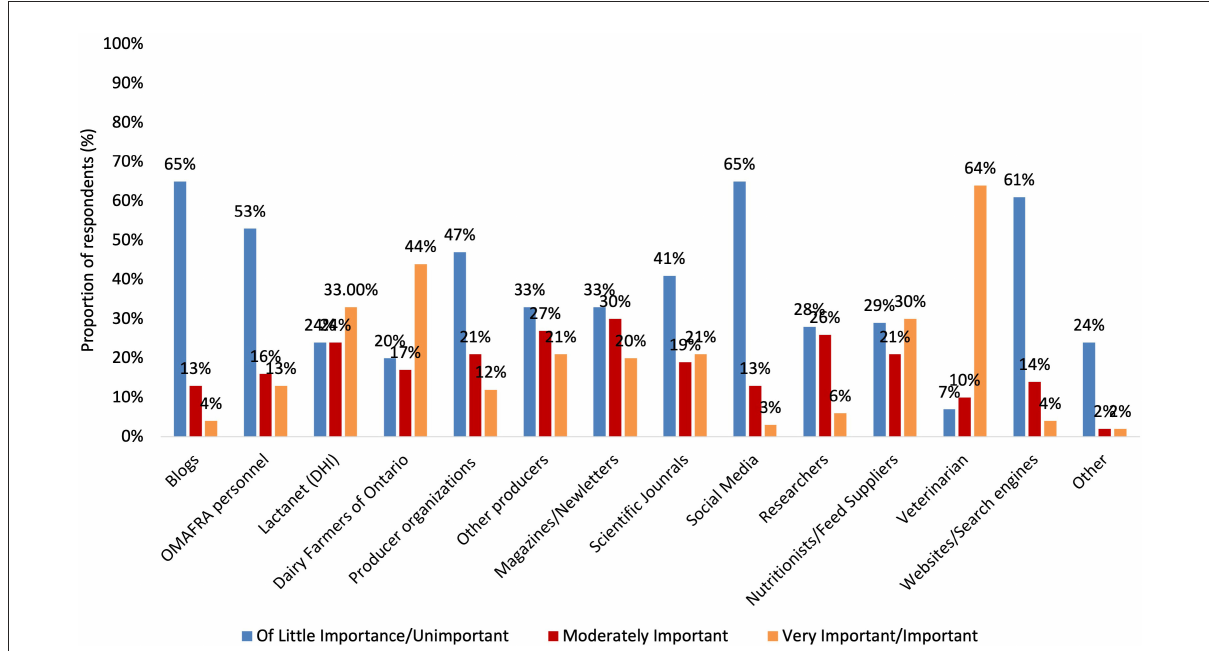
FIGURE1 Proportion of respondents ( n = 226) view on the importance (“very important/important,” “moderately important,” and “of little importance /unimportant”) of factors (body condition score, temperature, lameness, lactation status drug withdrawal time, mastitis, reproductive status, other disease/injury/illness, and ability of the cow to stand and stay standing for the duration of the trip) to assessment of cow fitness for transport immediately before loading, and whether or not factors were included in the farm cull cow standard operating procedure ( n = 182).